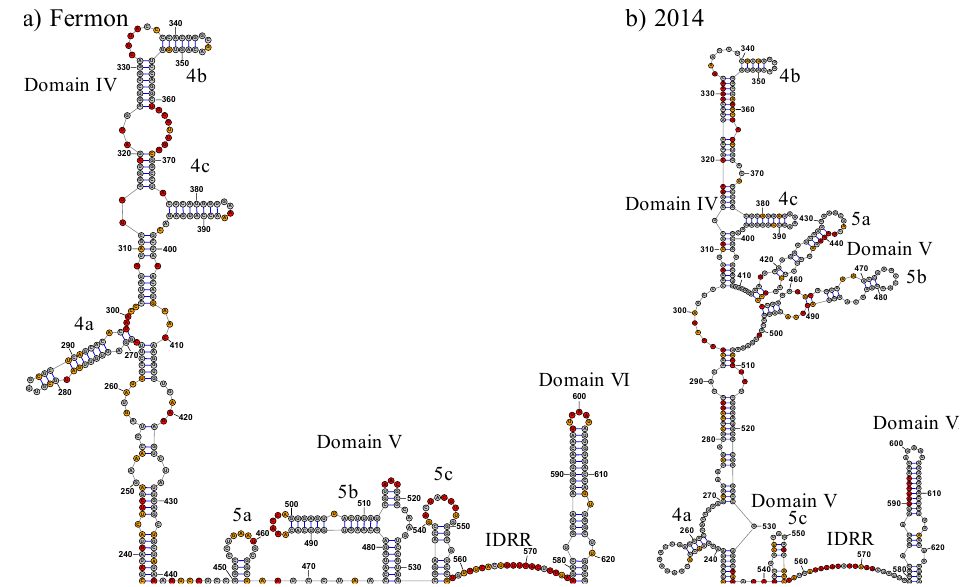
Figure 6. Secondary structures of domains IV and V of EV-D68 Fermon and 2014 Strains. ( a ) and ( b ) represent domains IV and V of the 5 ′ UTR of the Fermon and 2014 strains of EV-D68, respectively. The shape reactivity of each nucleotide is indicated by colored shading. Grey shading indicates little reactivity, with reactivity values below 0.40. Orange shading indicates moderate reactivity, with reactivity values between 0.40 and 0.85. Red shading indicates high reactivity, with values greater than 0.85.